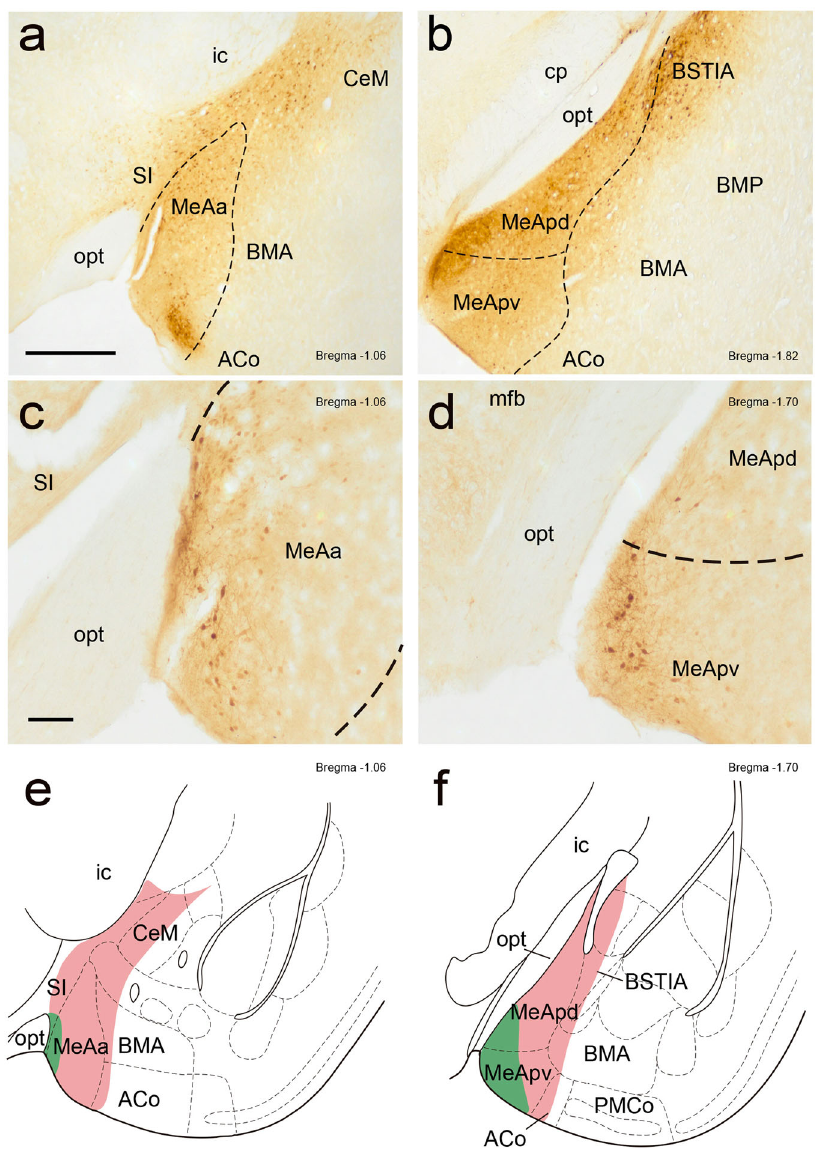
Fig. 3 Injection sites in the MeA showing the rostro-caudal extent of the DREADD infections. Photomicrographs showing the biggest ( a , b ) and the smallest ( c , d ) injection included in the analysis. Scale bar a , b : 500 µ m and c , d : 100 µ m. e , f Schematic reconstruction of coronal brain sections showing the extent of DREADD infections. Different coloured outlines represent the biggest (light pink) and the smallest (green) injection. The brain drawings are modi fi ed from ref. 61 . ACo anterior cortical amygdaloid nucleus, BMA anterior basomedial amygdaloid nucleus, BSTIA bed nucleus of the stria terminalis intraamygdaloid division, CeM medial part of the central amygdaloid nucleus, ic internal capsule, MeAa anterior medial amygdaloid nucleus, MeApv posteroventral medial amygdaloid nucleus, opt optic tract (opt), MeApd posterodorsal medial amygdaloid nucleus, SI substantia